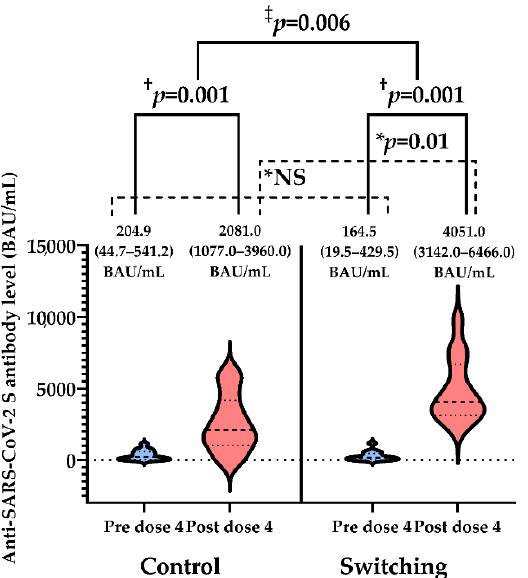
Figure 2. The anti-SARS-CoV-2 S antibody level (median [IQR]) pre- and post-fourth vaccination with BNT162b2 between the control group and the switching group. Baseline anti-SARS-CoV-2 S antibody level was not different between both groups (* p > 0.05, NS [not significant]). After vaccination with BNT162b2, anti-SARS-CoV-2 S antibody level increased in both groups († p = 0.001). Anti-SARS-CoV-2 S antibody level post-fourth vaccination with BNT162b2 in the switching group was significantly higher than the control group (* p = 0.01). The difference-in-differences was also significant (‡ p = 0.006). The horizontal dotted line indicates the cutoff point at 0.823